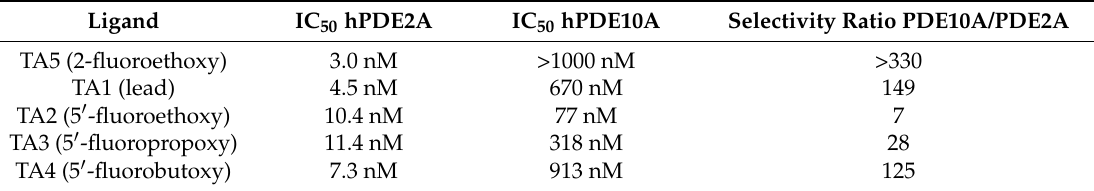
Table 1. IC 50 values of the novel 2-fluoroethoxy derivative TA5 for the inhibition of human PDE2A and human PDE10A compared to our already published data for the lead compound TA1 and the PDE2A ligands TA2 – 4 [13,19,20]. Ligand IC 50 hPDE2A IC 50 hPDE10A Selectivity Ratio PDE10A/PDE2A TA5 (2-fluoroethoxy) 3.0 nM